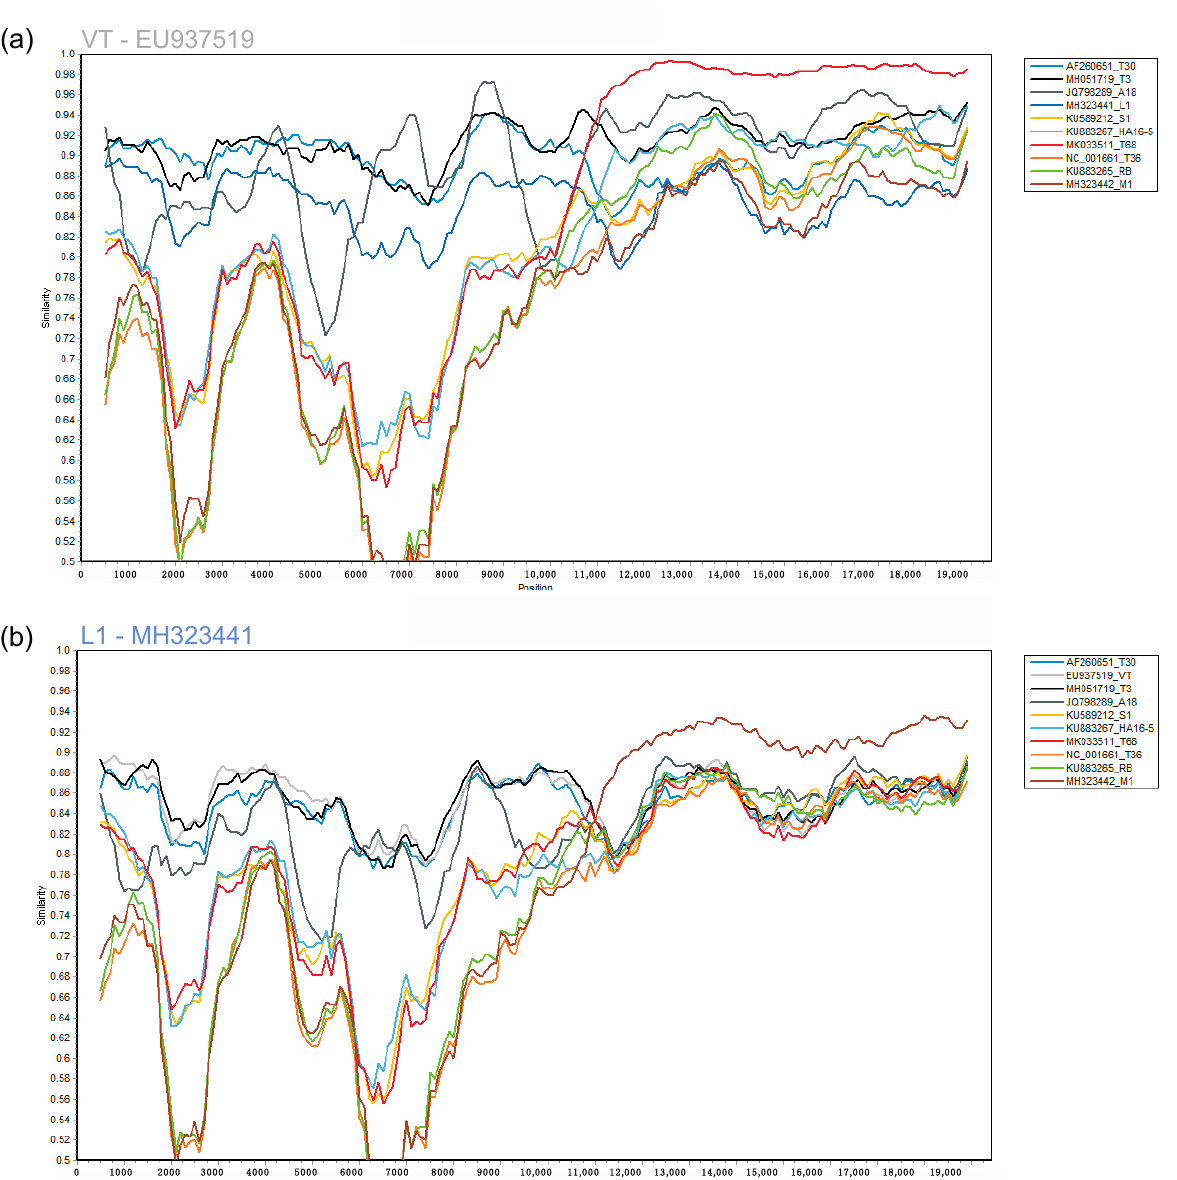
Figure 2. The complete genome of a single citrus tristeza virus (CTV) genotype sequence was compared to a representative sequence of each of the other 10 genotypes at the nucleotide level in a similarity plot. Similarity plots were constructed from a multiple alignment of the eleven genotypes using a window size of 1000 nucleotides (nt) and a step size of 100 nt. ( a ) Genotype sequence VT (EU937519) was selected as the query sequence; ( b ) Genotype sequence L1 (MH323441) was selected as the query sequence.